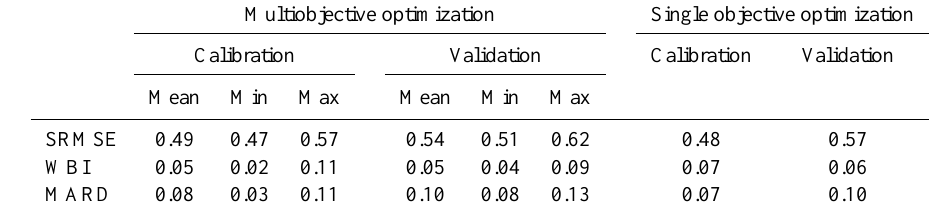
Table 2. Statistics of three objective functions associated with multiobjective optimization and single objective optimization.